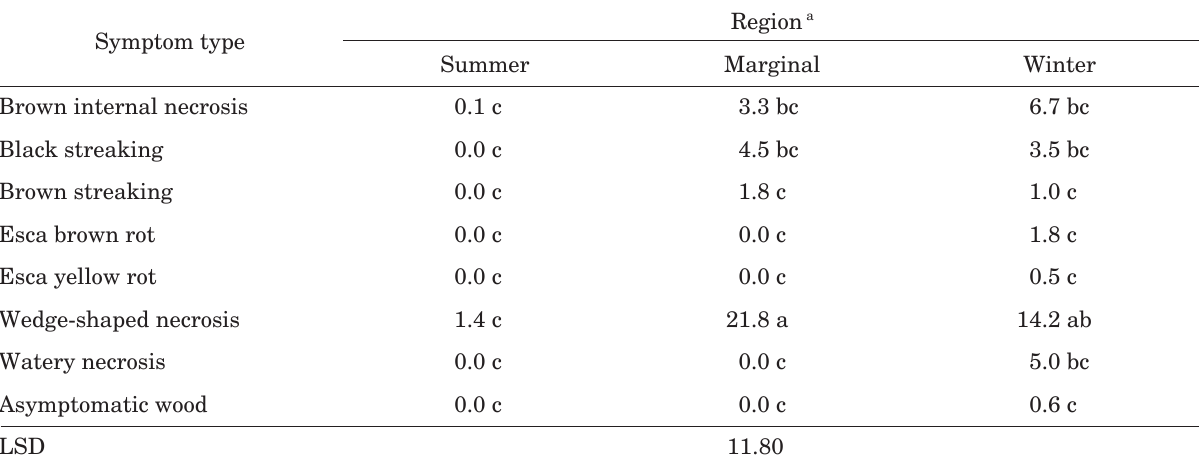
Table 5. Mean incidence of Phomopsis spp. in isolates from vines displaying different symptoms in the summer, mar- ginal and winter rainfall regions of South